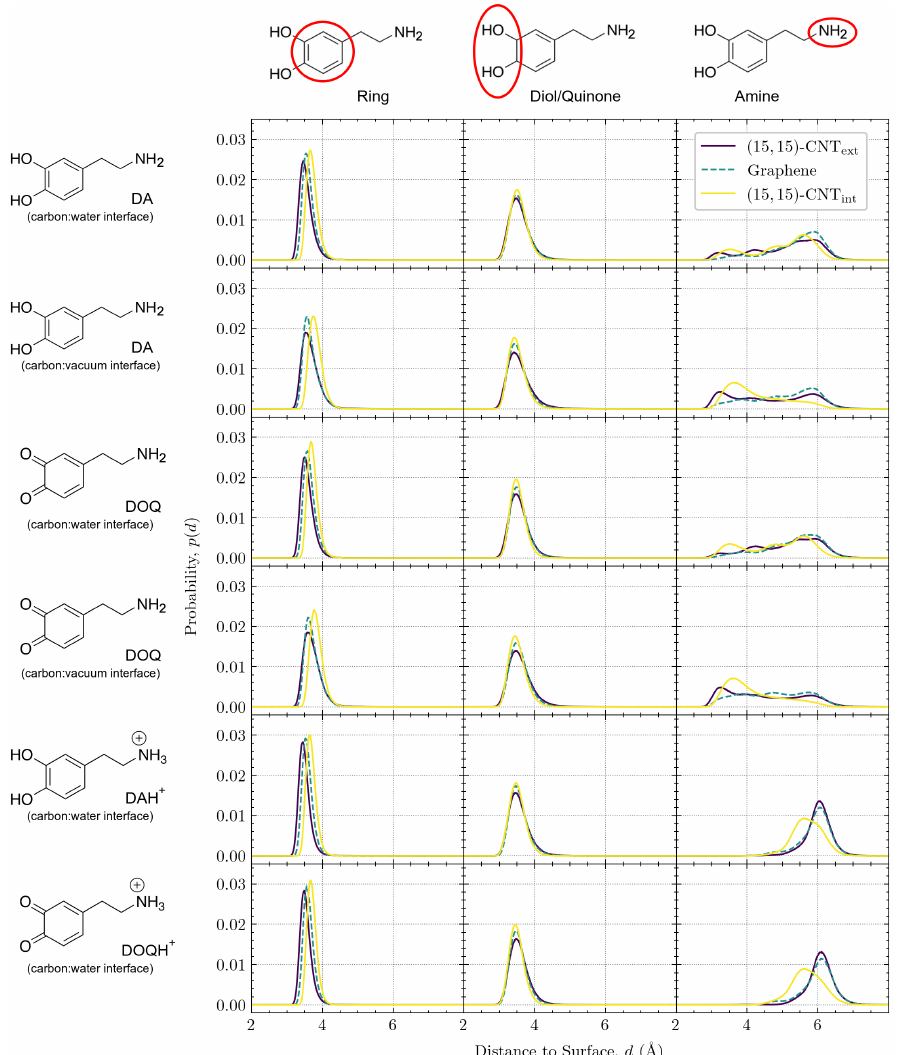
Figure 7. Vertical distributions of DA and DOQ moieties at the carbon:water and carbon:vacuum interfaces. From left to right, three columns show the vertical distributions of the aromatic ring, the diol/quinone moiety, and the amine group, respectively, with d representing the distance between that moiety’s COM and the closest point on the surface. From top to bottom, the six rows correspond to DA, DA in vacuum, DOQ, DOQ in vacuum, DAH + , and DOQH + . Colored curves within each subplot indicate the distributions at the flat graphene or the interior and exterior ( 15,15 ) - CNT